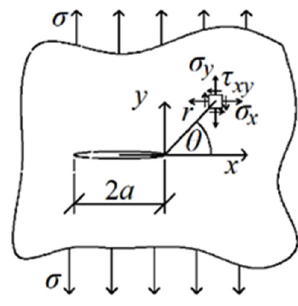
Figure 2. Griffith’s crack.